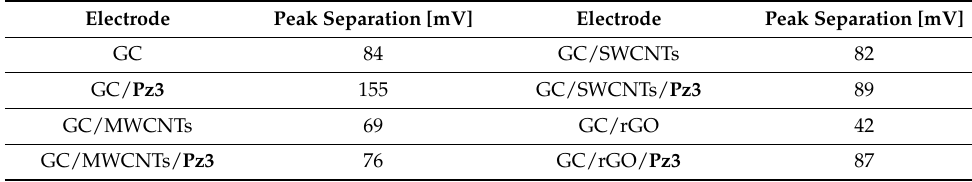
Table 1. Comparison of separation peaks for all tested